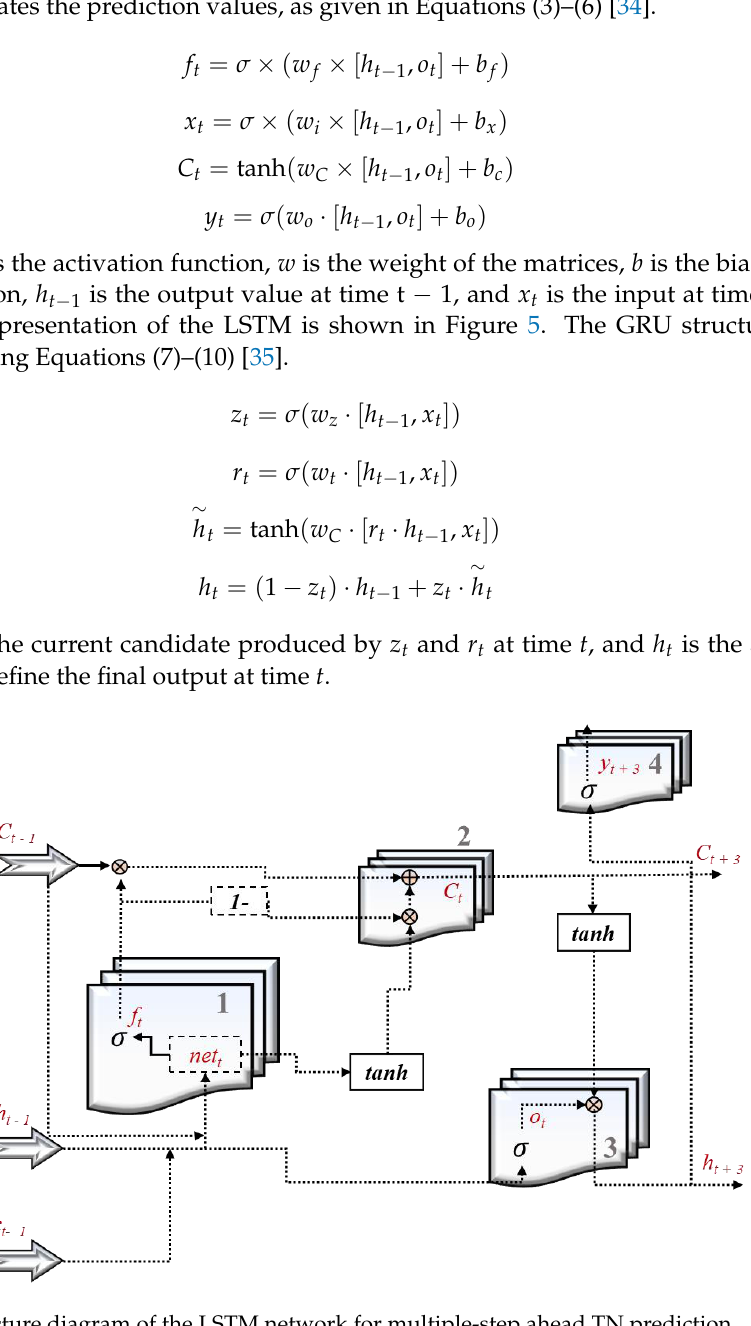
Figure 5. Structure diagram of the LSTM network for multiple-step ahead TN prediction.